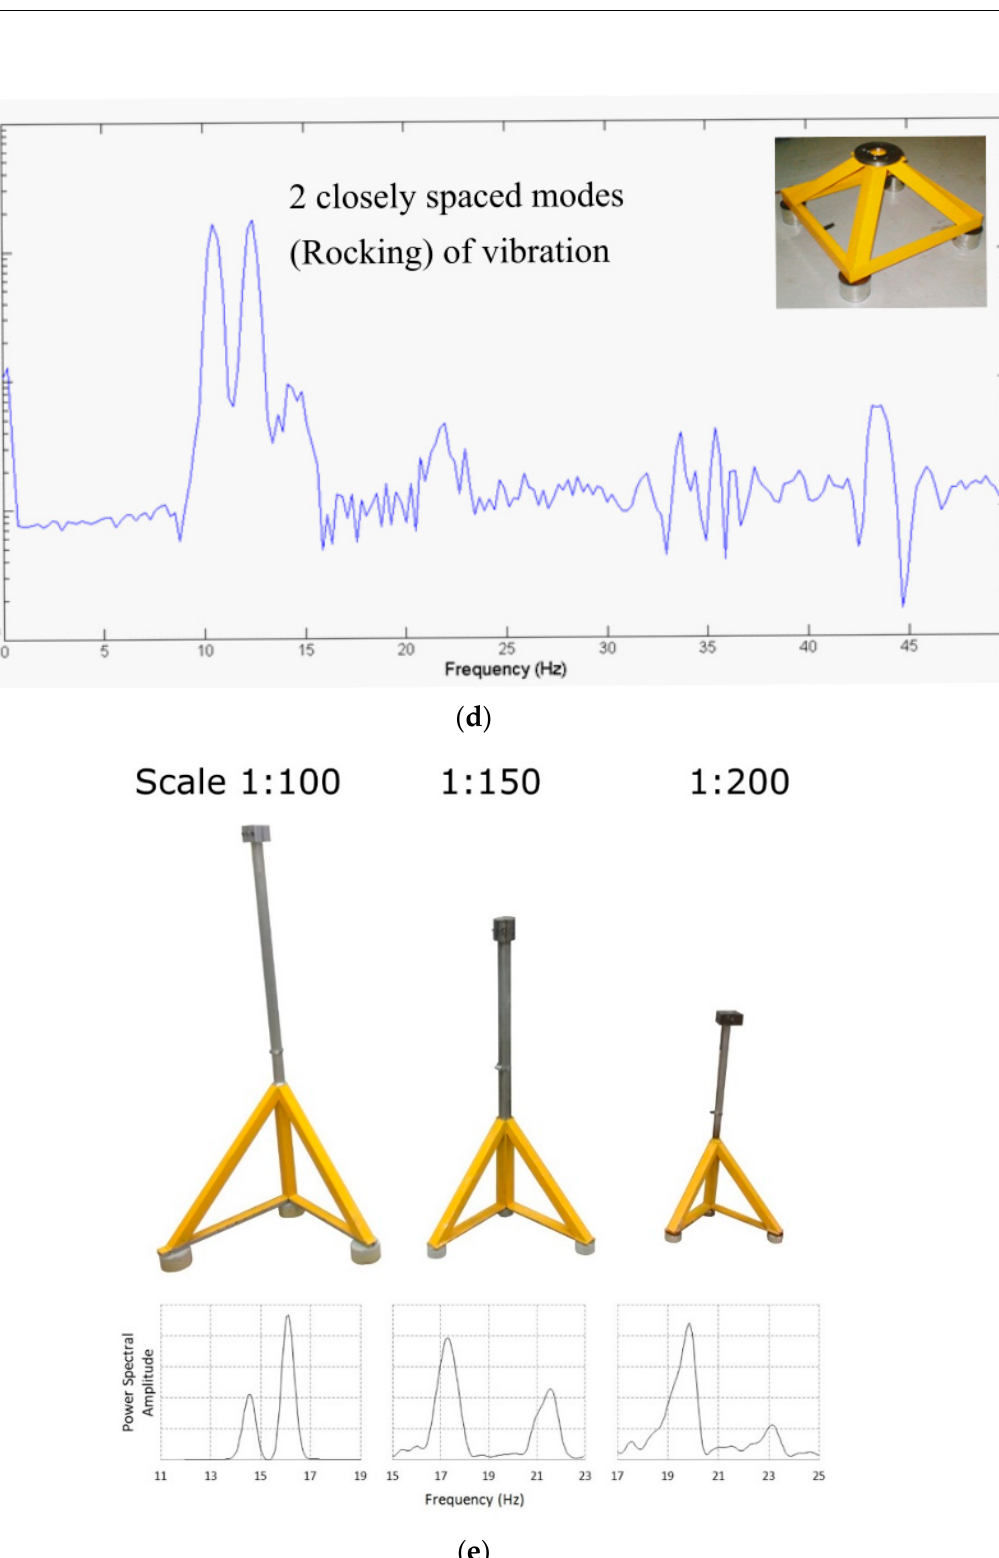
Figure 23. ( a ) The shallow foundation models studied. ( b ) Free vibration test to obtain fixed-base frequency. The test helps to identify the role of foundation plays in overall damping. ( c ). Welch power spectral density estimate obtained through the free vibration test of the twisted jacket foundation after 25,000 loading cycles (See Figure 14 for the model). ( d ) Free vibration response of the tetrapod structure in Figure 17 ( e ) Modes of vibration with two closely spaced modes.